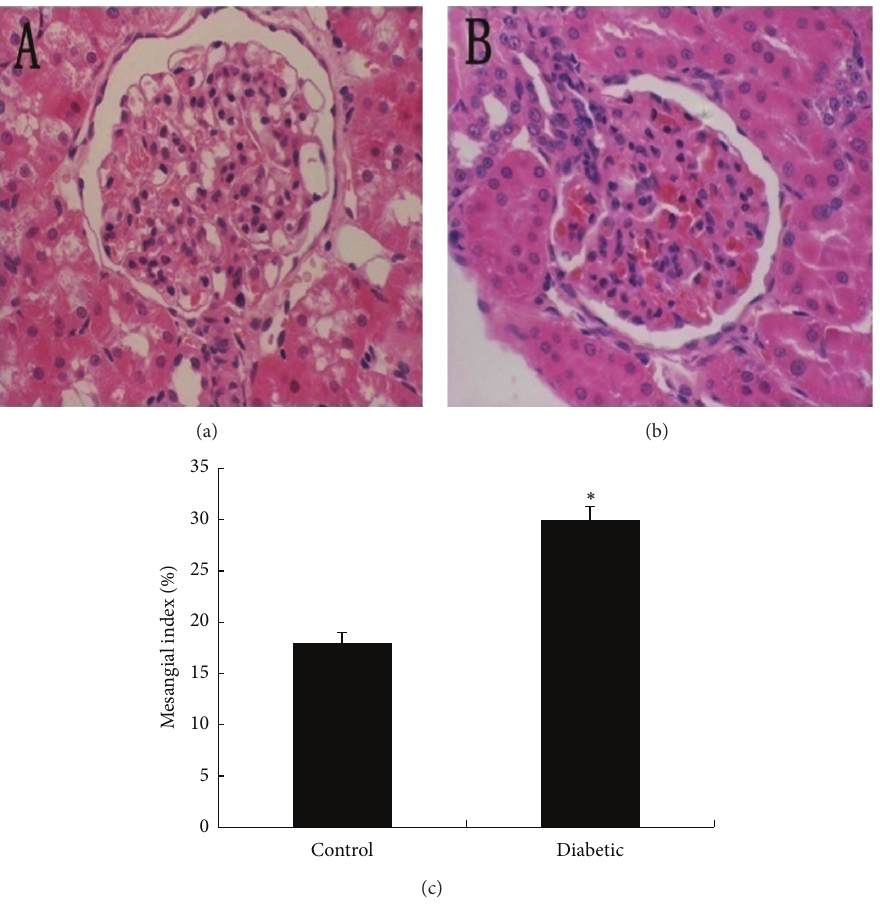
Figure 2: (a)-(b) Representative light microscopy images of glomeruli (original magnification, 400 × ) in nondiabetic control rats (a) and diabetic rats (b). (c) Mesangial index in control and diabetic rats, expressed quantitatively by calculating the percentage of the total glomerular area. ∗ 𝑃 < 0.01 versus (c) 𝑛 = 6 for each group. Each column represents the mean ±